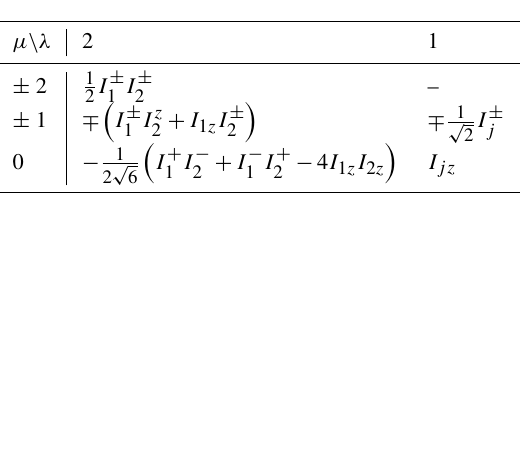
Table C1. Eigenoperators of Hamiltonian for a homonuclear cou- pled spin 1 / 2